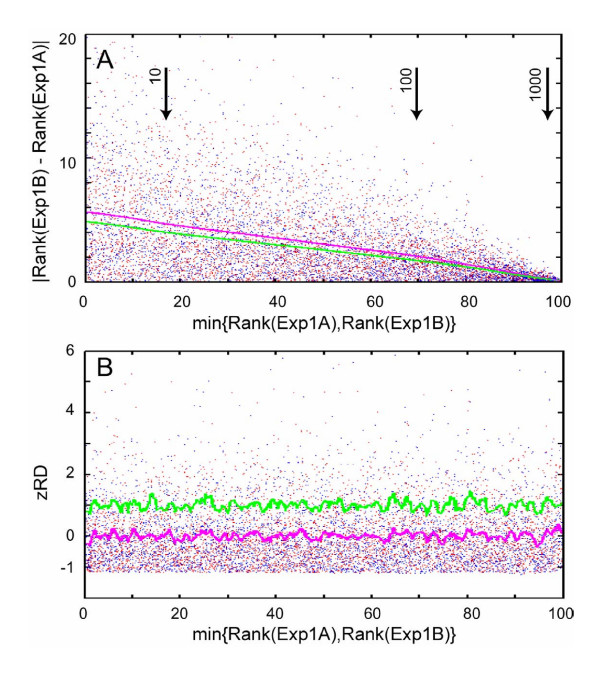
Effect of positive variation normalization. A – Increasing rank differences in the comparison Wt-t0b vs Wt-t0a are plotted (in red) against the rank of Wt-t0a. Similarly, increasing rank differences in the comparison Wt-t0a vs Wt-t0b are plotted (in blue) against the rank of Wt-t0b. In the nomenclature of the TOR experiment, Wt and Mu refer, respectively, to strains SH100 and SH121, t0, t1 and t2 refer to 0 h, 2 h and 6 h time points, and a and b indicate the replicates. A sliding window of 100 points was moved by steps of 30 points. At each position, the mean (upper magenta curve) and std (lower green curve) were plotted and the resulting jagged lines were smoothed by a fitting procedure [25]. The vertical arrows indicate the position of 10, 100 and 1000 signal on the 0–100 rank scale. B – Distribution of zRD (mean (magenta curve) and std (green curve) are not smoothed).